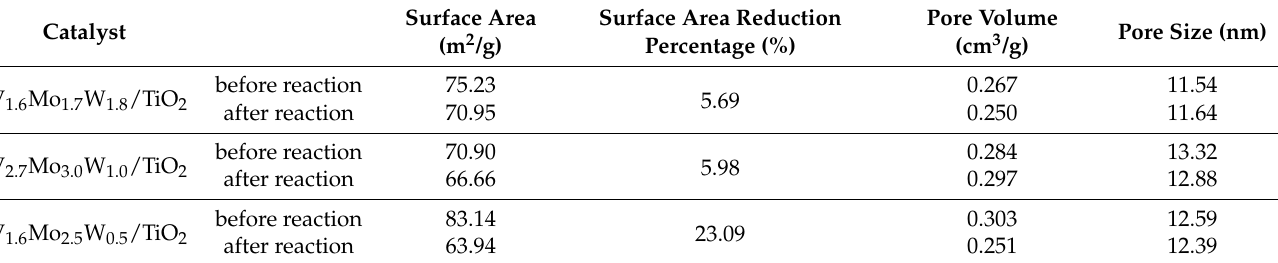
Table 1. BET test results of the three